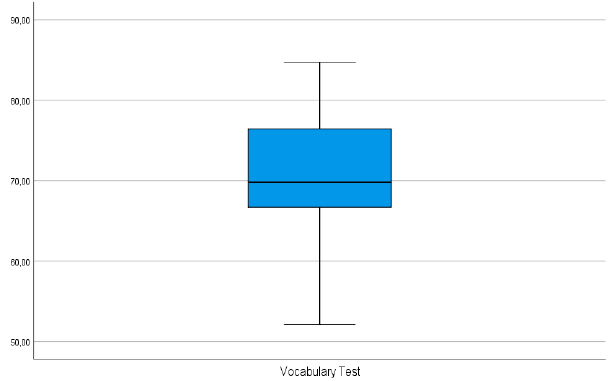
Figure 9. Boxplot: Results of the lexical decision task.